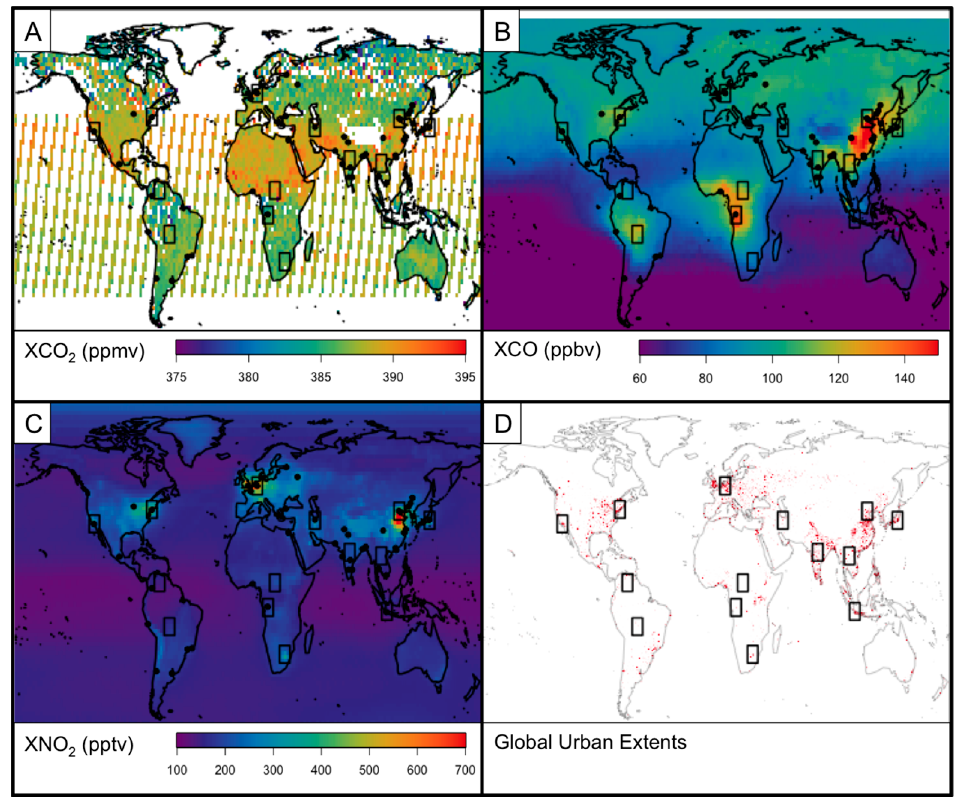
Figure 1. Annual mean retrieved concentrations of XCO 2 ( A ), XCO ( B ), and XNO 2 ( C ) for the year 2010 used in this work. Panel ( D ) shows the urban extents as defined by the Anthromes dataset. Megacity locations are shown as black points, and the boxes represent the combustion regions selected for this analysis.